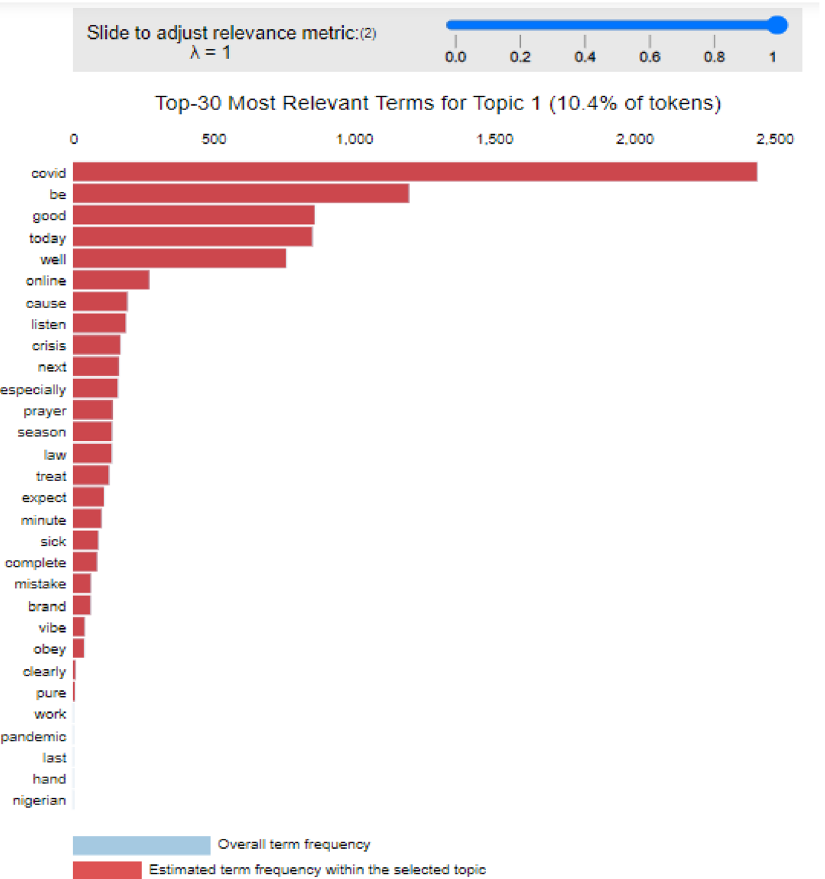
Fig. 13 Diagram for text and bar representing each topic selected on the